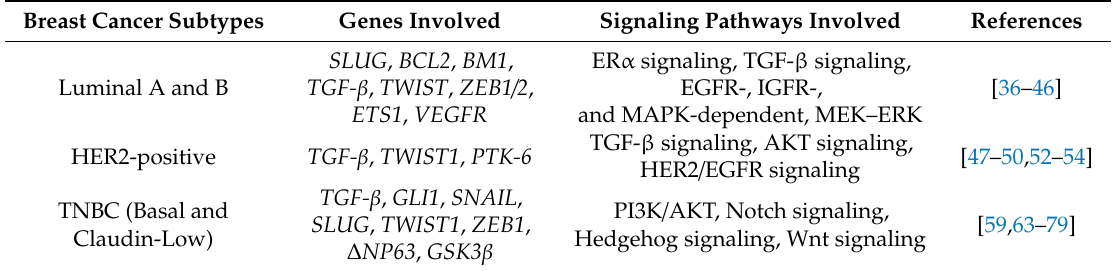
Table 1. Table shows genes and pathways involved in mediating EMT in di ff erent subtypes of breast. Breast Cancer Subtypes Genes Involved Signaling Pathways